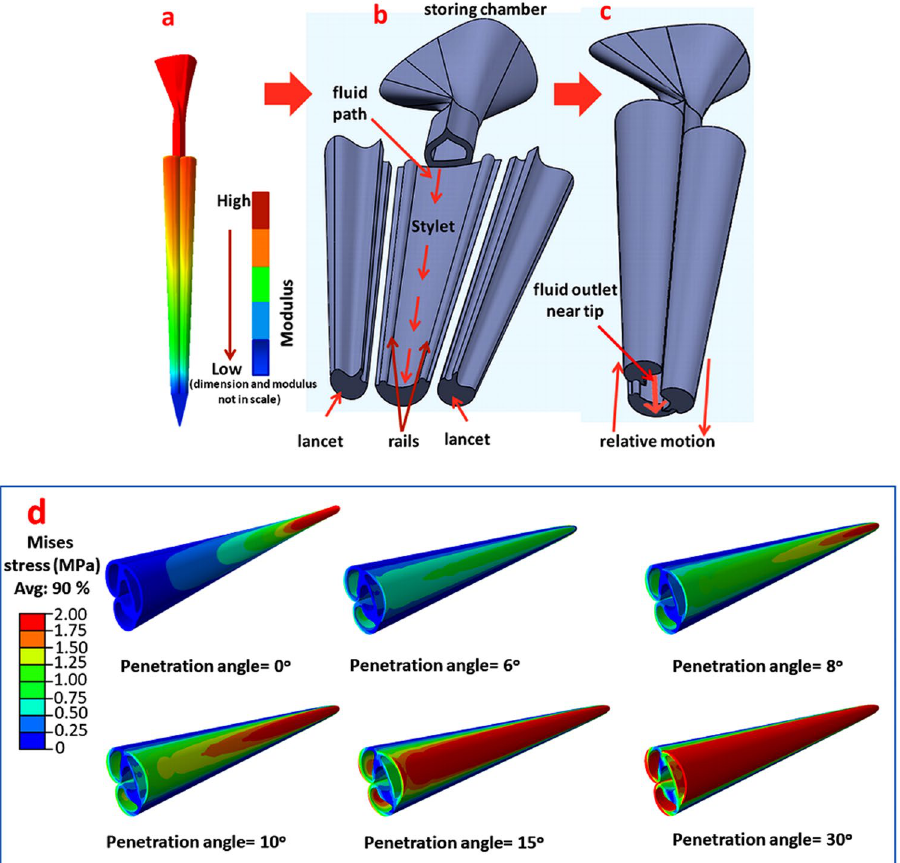
Figure 10. ( a ) The proposed design of an artificial microneedle mimicking the stingers, ( b ) The magnified view of the internal structure of the microneedle with all components (tip has been removed), ( c ) The relative sliding motion of lancets to generate an outlet near tip in magnified view, ( d ) The von Mises stress distribution in the microneedle at different penetration angles. The colour variation represents the functionally graded materials in the micro syringe-needle where the mechanical properties increase along the longitudinal direction from tip to base. A gap is generated near the tip due to sliding relative motion of lancets on the rails of the stylet, and the numbing fluid stored in the storing chamber will be pumped through the one-way valve from the chamber to the targeted body. In ( d ), the minimum stress distribution has been observed at the specific penetration angle of